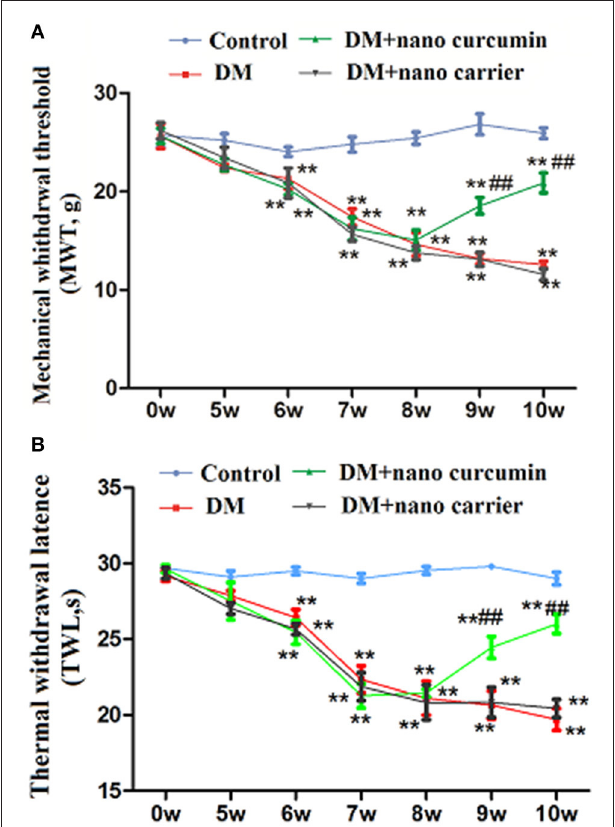
FIGURE 1 | Effects of nanoparticle-encapsulated curcumin on mechanical or thermal hyperalgesia in DM rats. (A) The MWT in the DM group was lower than that in the control group. The MWT was higher in DM rats treated with nanoparticle-encapsulated curcumin than that in the untreated DM group. No difference was observed between the DM + nanoparticle-encapsulated carrier group and the DM group ( p > 0.05). Each group comprises seven rats. Data are displayed as means ± SEMs. ** p < 0.01 compared to the control group; ## p < 0.01 compared to the DM group. (B) The TWL in the DM group was lower than that in the control group. The TWL was higher in DM rats treated with nanoparticle-encapsulated curcumin than that in the untreated DM group. No difference was observed between the DM + nanoparticle-encapsulated carrier group and the DM group ( p > 0.05). Each group comprises seven rats. Data are displayed as means ± SEMs. ** p < 0.01 compared to the control group; ## p < 0.01 compared to the DM